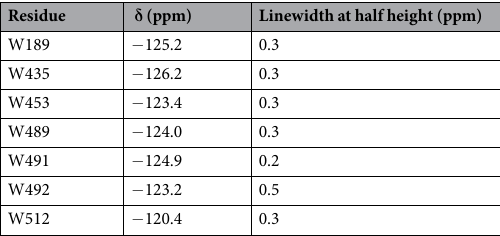
Residue δ (ppm) Linewidth at half height (ppm)